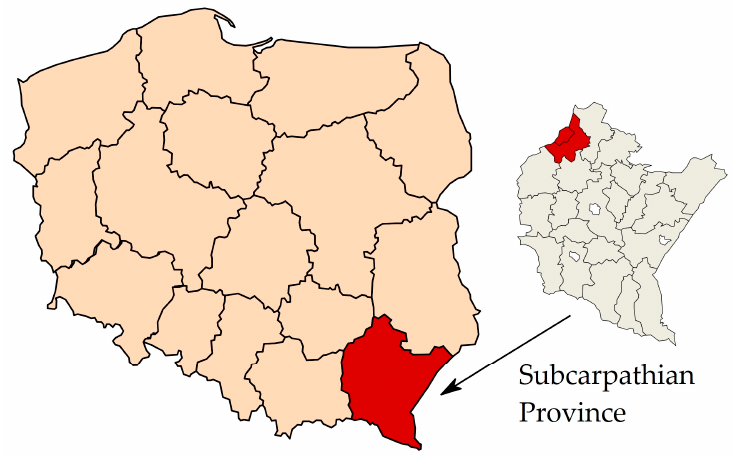
Figure 1. Location of the examined water supply system in Poland’s Subcarpathian Province.